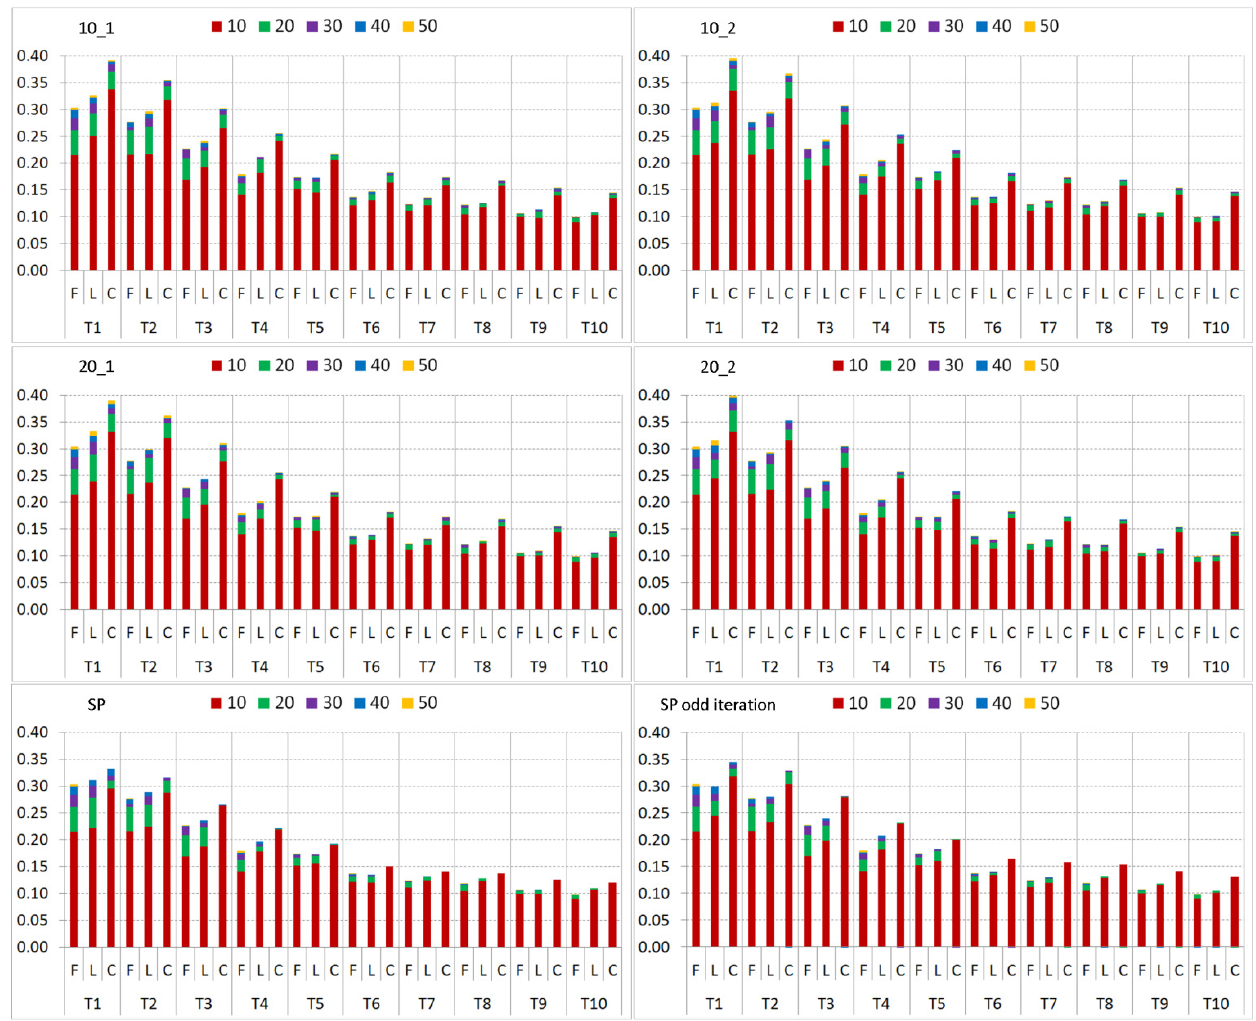
Figure 9. Improvements of self-training per 10th iteration for different training sets T using the three selection methods for the unlabeled samples over the four circular combinations and two superpixel methods using RF. The selection methods are abbreviated as F ( full ), L (NH ), and C (NH L C